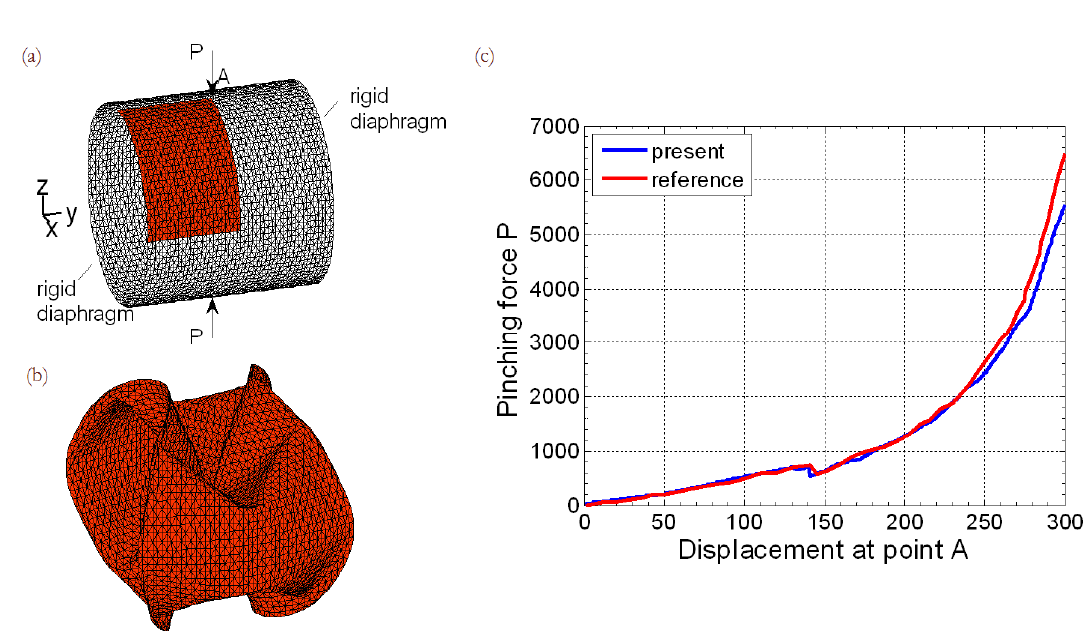
Figure 3: Pinching of a cylindrical shell with diaphragms. (a) Geometry, boundary conditions and finite element mesh; (b) Deformed configuration; (c) Comparison of load-displacement diagram between the proposed algorithm and reference solution (see